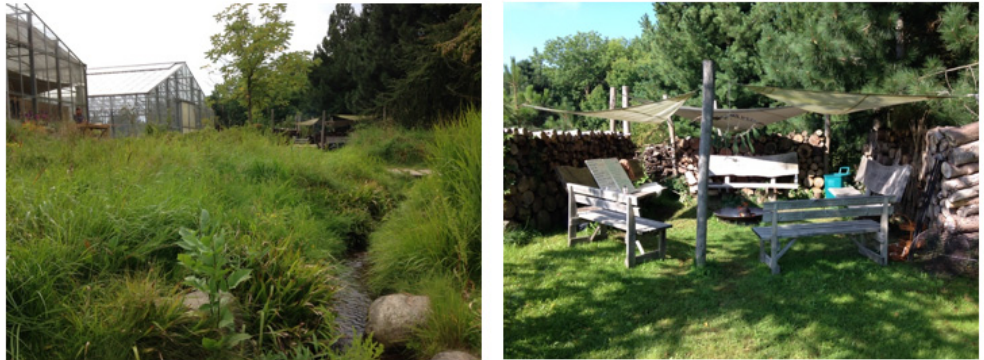
Figure 1. The Therapy Garden Nacadia ® . Photos: Trine Fryjana Theede.